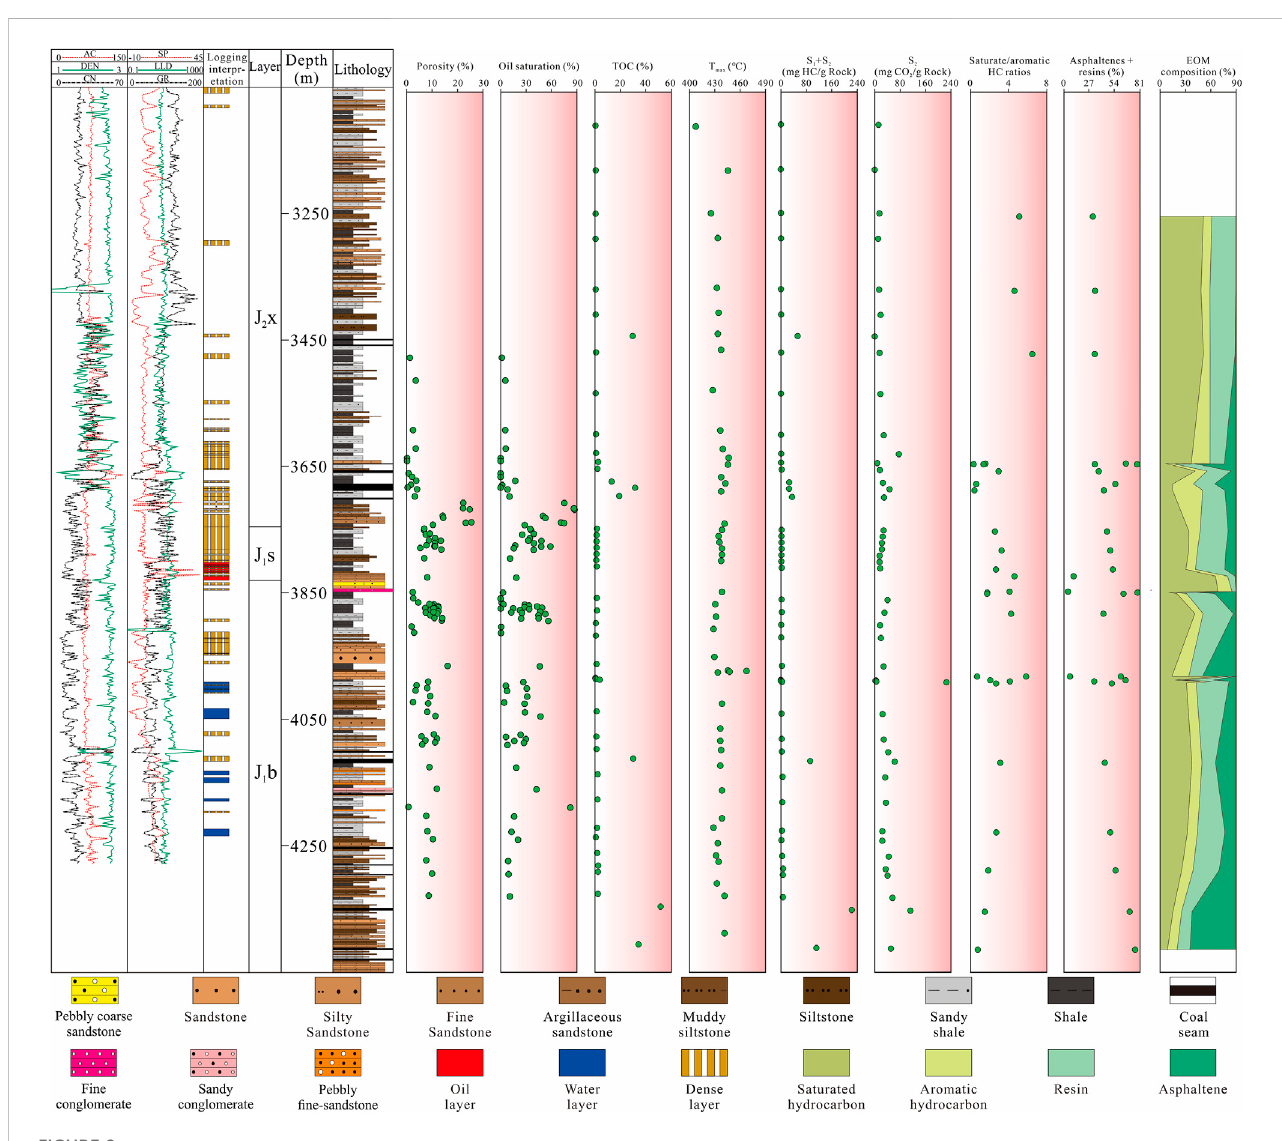
FIGURE 2 Thestratigraphiccolumn,distributionsinporosity,oilsaturation,TOCcontent,andRock-Evaldata,aswellascompositionsofextractableorganicmatter of the EF 2 well for the Jurassic organic-rich shale in the East Fukang Sag, Junggar Basin, China TOC and Rock-Eval data after Qiao et al.